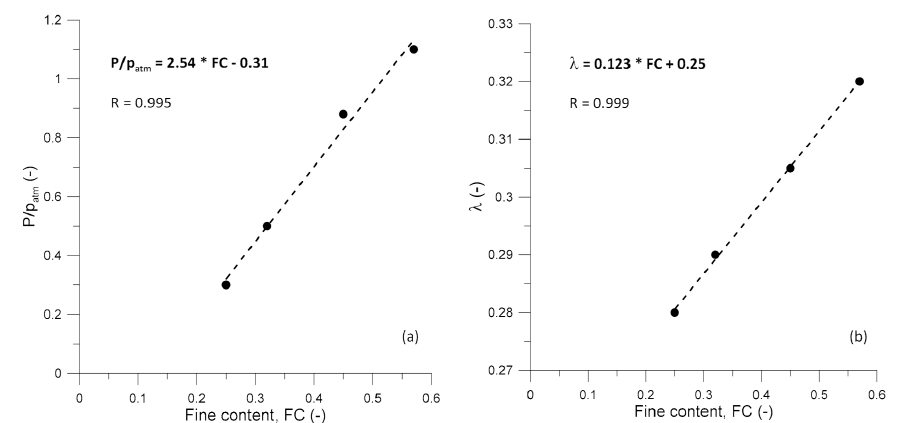
Figure 4. Fitting curves of the water retention model parameters as a function of the fine content, FC: